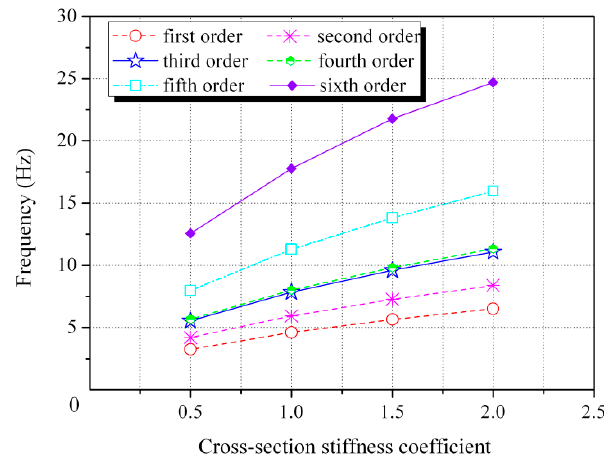
Figure 10. The first six modal frequencies with different cross-section stiffness.